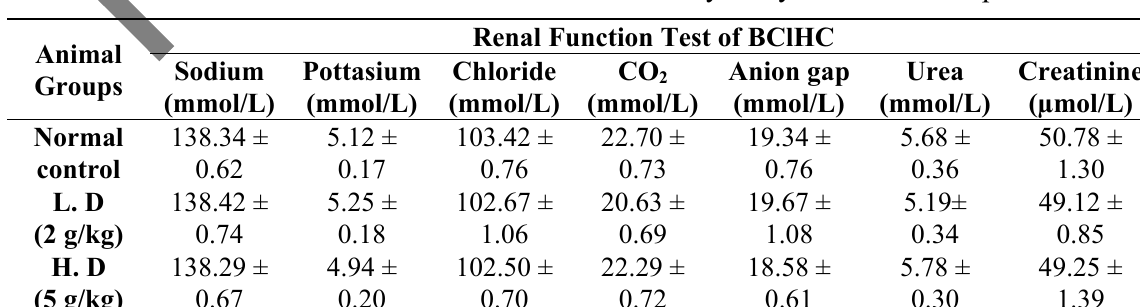
Table 1. Renal function test of rats in acute toxicity study of BClHC